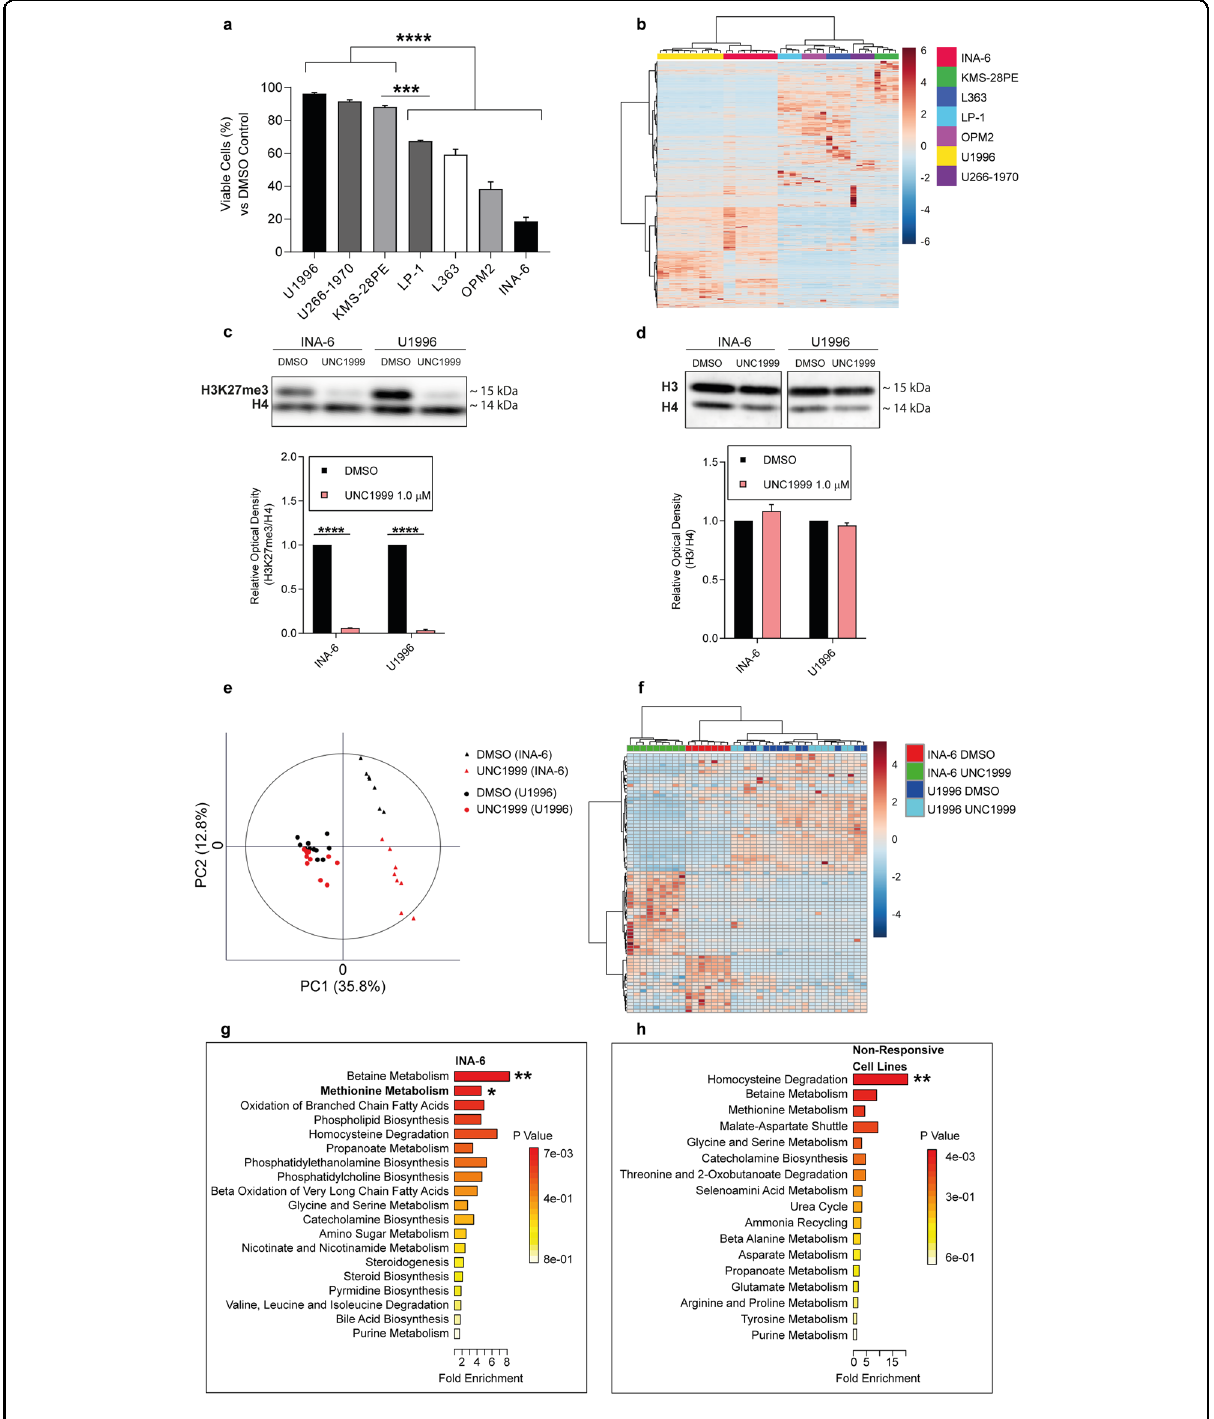
Fig. 2 (See legend on next